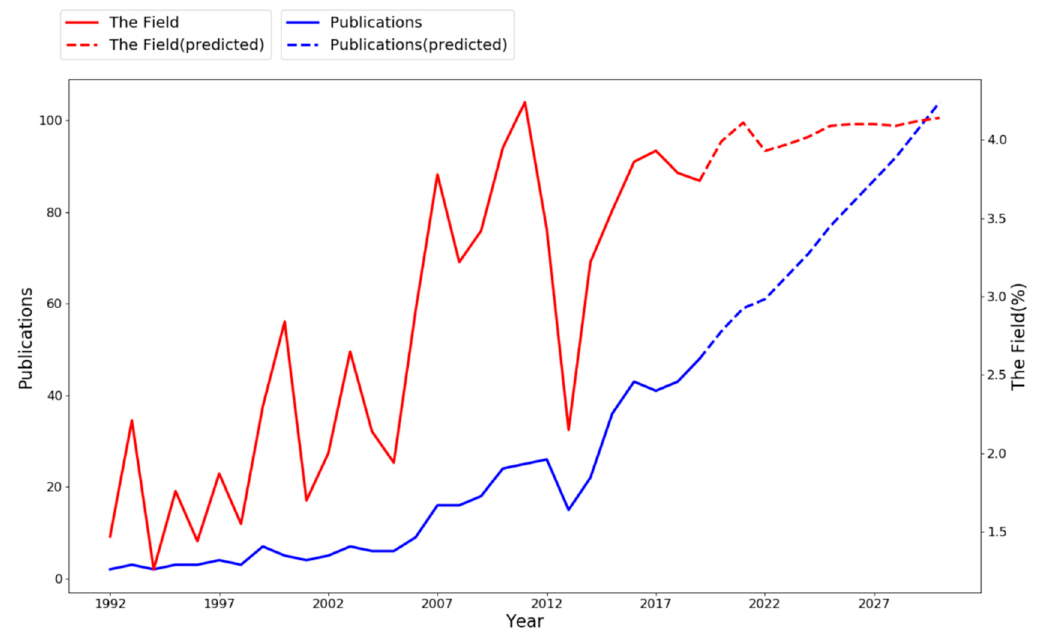
Figure 1. The publications on HCWs + OH and the number of articles on HCWs + OH / total articles in the field of OH.